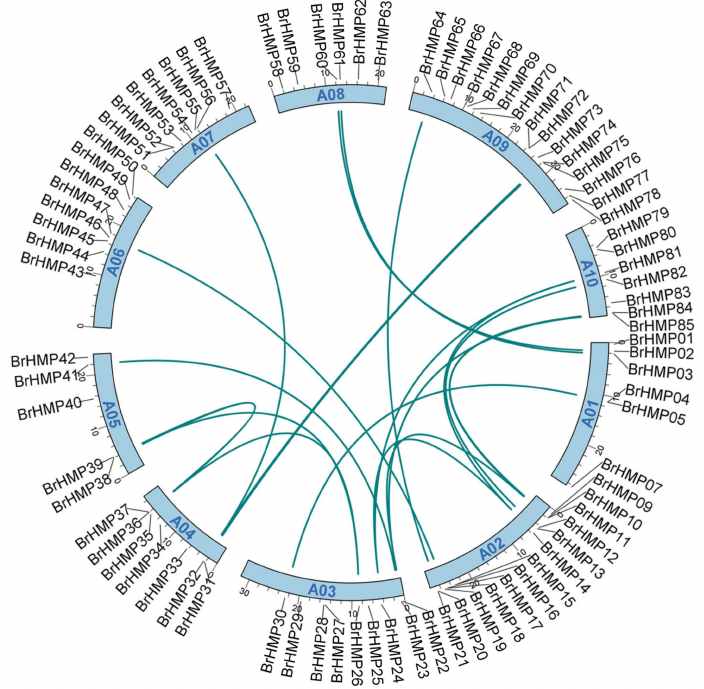
Figure 1. Chromosome localization and duplication events of BrHMP genes. The green lines indicate segmentally duplicated gene